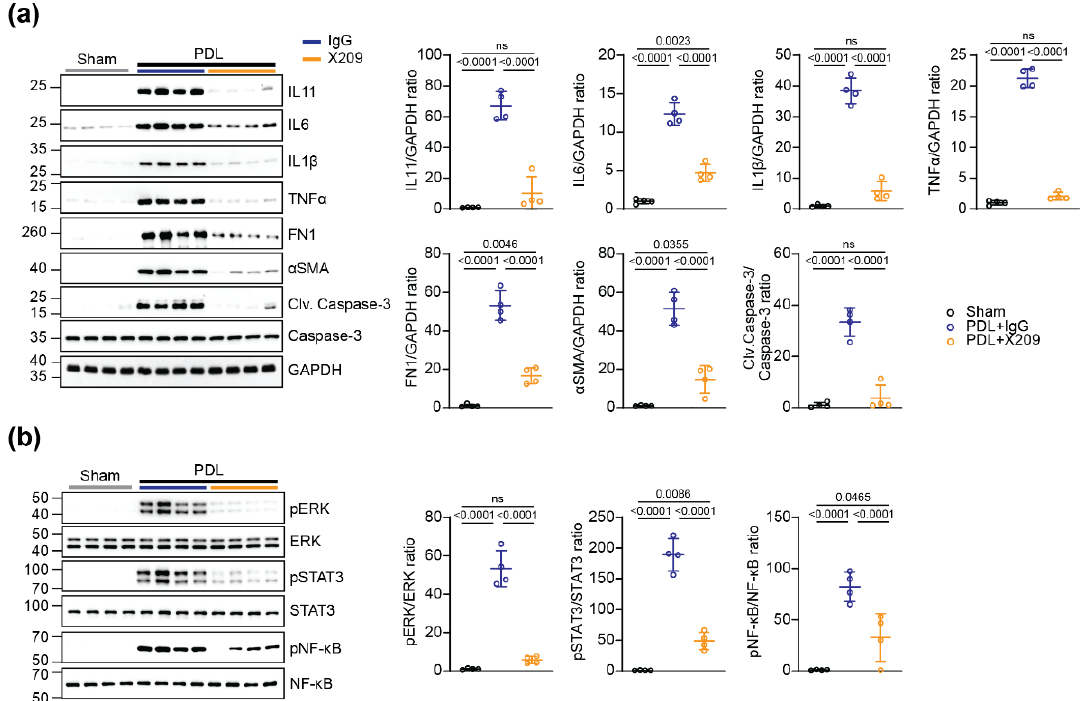
Figure 5. IL11RA antibody treatment attenuates pancreatic inflammation and pathological signalling in a mouse model of pancreatitis. ( a ) Western blot analysis of IL11, IL6, IL1β, TNF, FN1, αSMA, cleaved (Clv.) and total caspase-3 and ( b ) phosphorylated and total protein levels of ERK, STAT3 and NF-kB in lysates from the ligated splenic lobes of X209 or IgG treated mice (n = 4/group). GAPDH served as loading control in ( a ). p values were determined by one way ANOVA (Tukey’s correction).